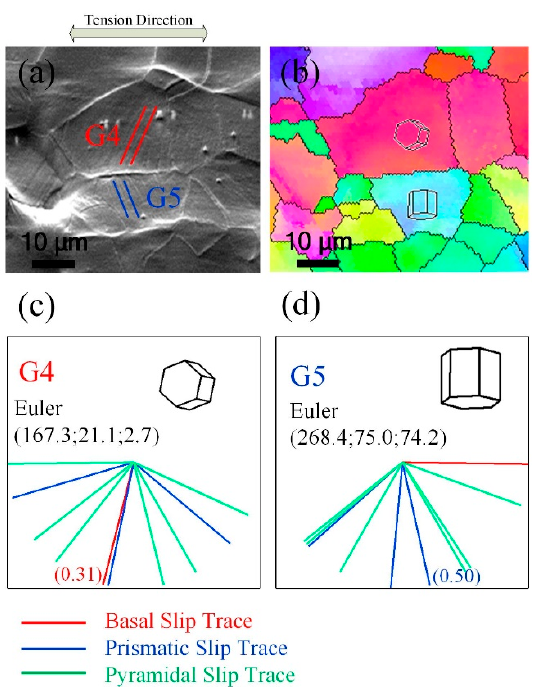
Figure 5. ( a ) SEM micrograph of Mg–8.0Gd–3.0Y–0.5 Zr alloy after tension test at strain of 0.1; ( b ) the corresponding IPF map; ( c ) possible slip trace directions in Grain 4; ( d ) possible slip trace directions in Grain 5.